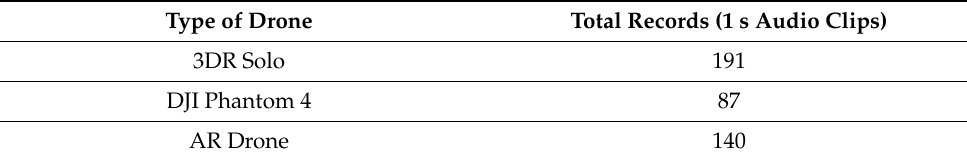
Table 2. Additional drones per